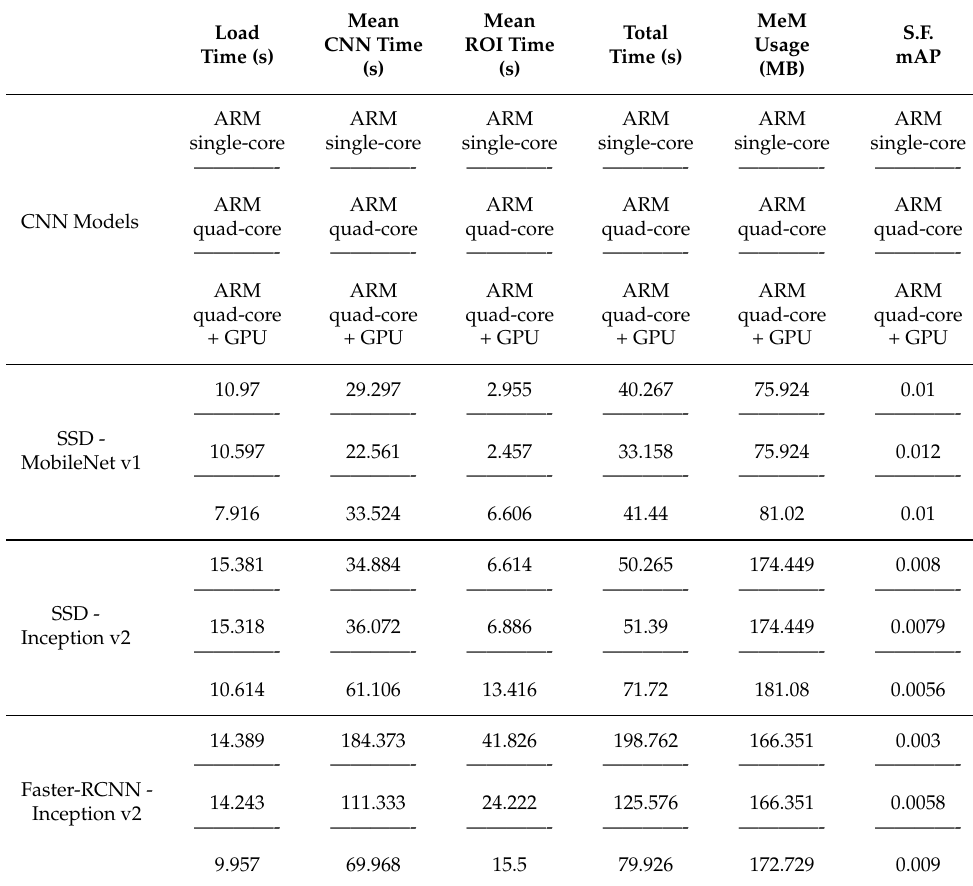
Table 6. Experimental Scenario II, RPi ARMv7, ARMv6 single-core and Jetson Nano CPU ARMv7 + GPU performance comparison